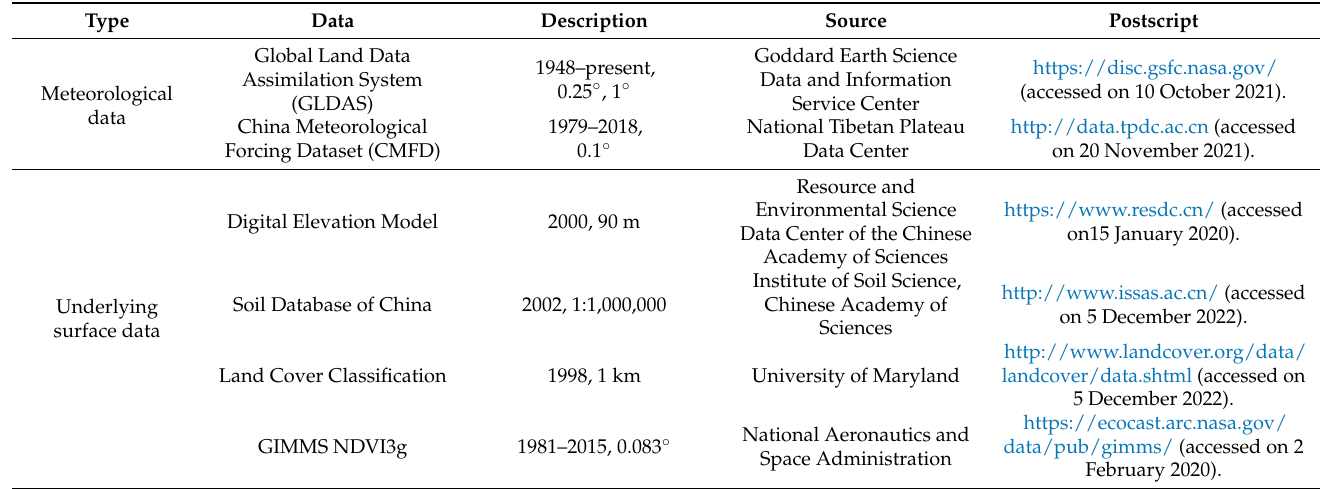
Table 1. The detailed information of all the datasets in the current study.